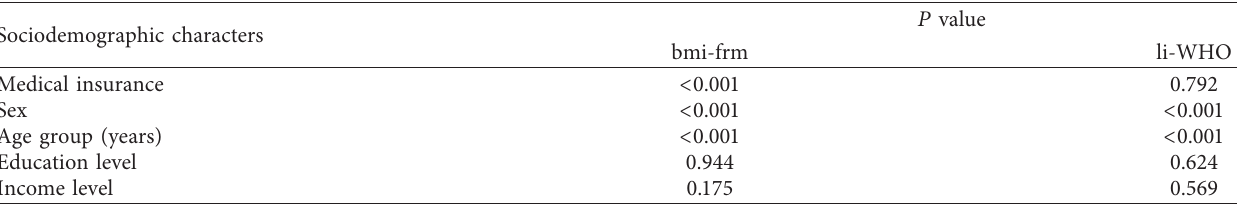
Table 3: bmi-based Framingham risk and low-information WHO risk prediction according to various sociodemographic characters. Sociodemographic characters